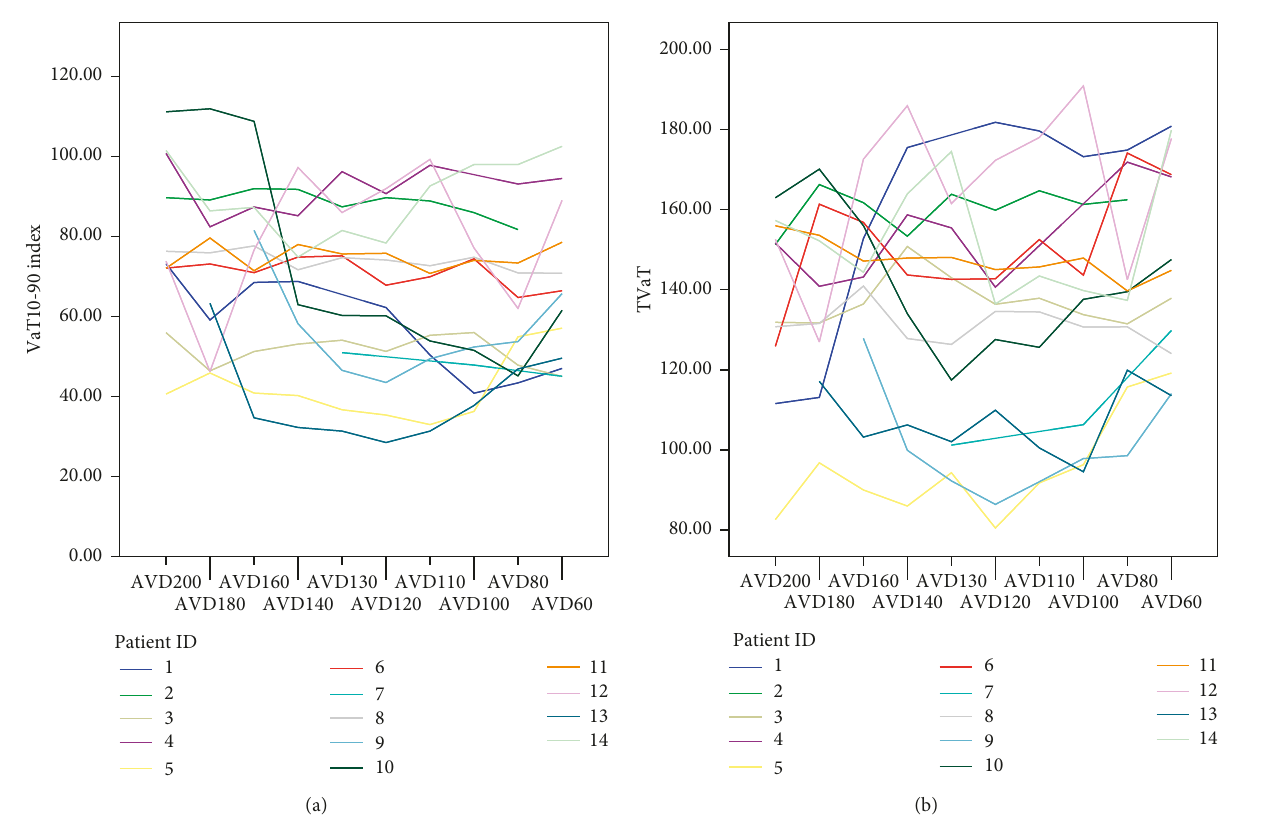
Figure 4: VaT 10-90 and TVaT values in each patient versus the AVD setting. AVDXXX, atrioventricular delay at XXX milliseconds; TVaT, total ventricular activation time; VaT10-90 index, ventricular activation time between percentile 10 and 90 obtained. Table 4: Effects of VV intervals on mean ventricular parameters. LVOT VTI (cm)